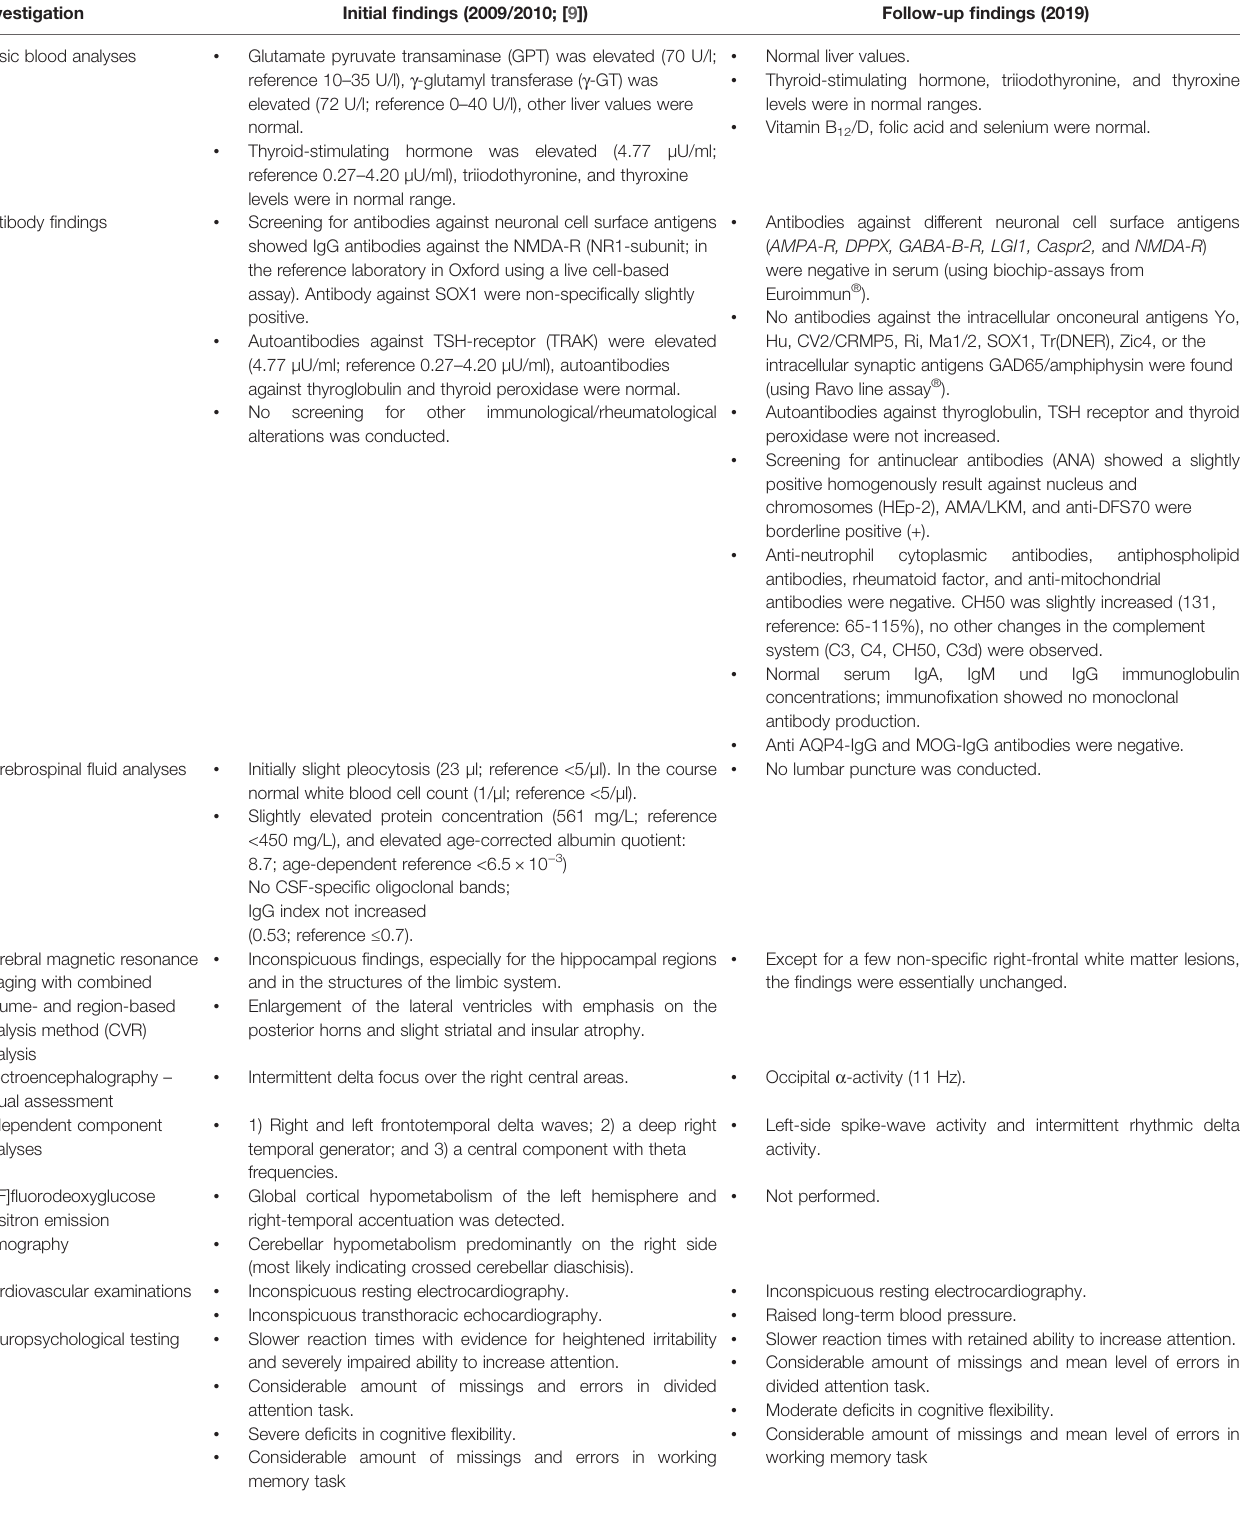
TABLE 1 | Diagnostic fi ndings, initially (2009/10) and at follow-up (2019). Investigation Initial fi ndings (2009/2010; [9]) Follow-up fi ndings (2019) Basic blood analyses Normal liver values.